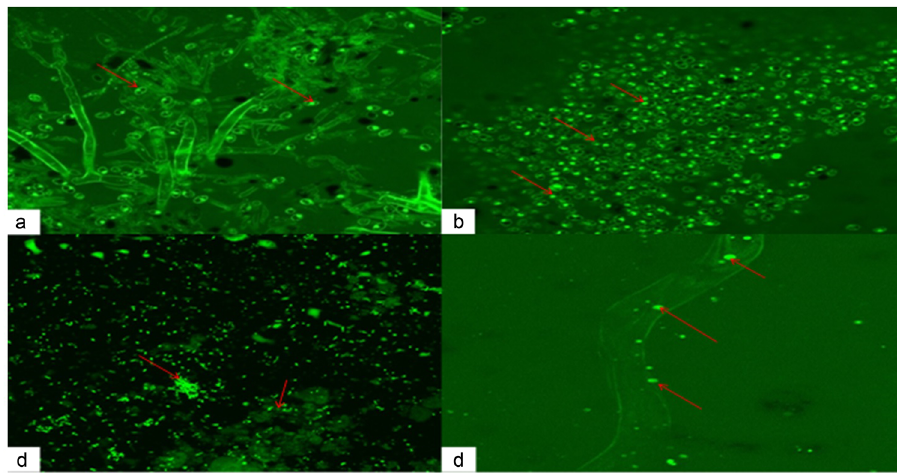
Figure 3: Confocal microscopic images of test pathogens: ( a and b ) penetration of SiO 2 - NPs in the mycelia and conidia of P. vexans ; ( c ) SiO 2 - NPs attached with cells of R. solanacearum ; and ( d ) penetration of SiO 2 - NPs in M. incognita J 2